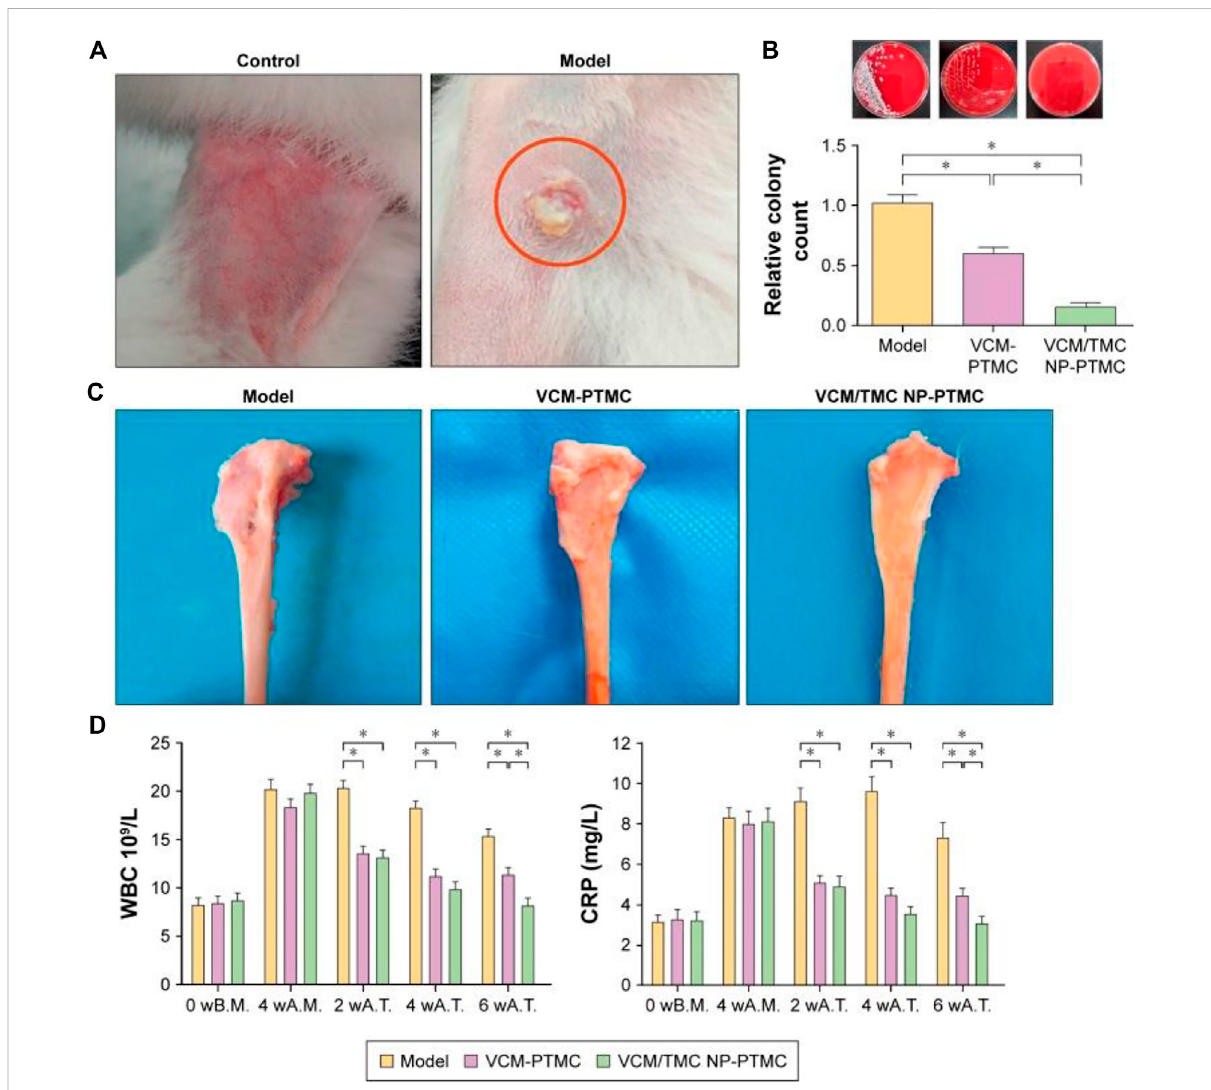
FIGURE 3 The antibacterial activity of VCM-PTMC and VCM/TMC-loaded PTMC nanoparticles. (A) The appearance of the rabbit legs at the fourth week after infection with Staphylococcus aureus . (B) A typical photograph of bacterial colonies forming on sheep blood agar plates and the number of bacterial colonies in the tibia marrow counted following overnight incubation. (C) Typical photographs of the tibia underwent 8 weeks of treatment with VCM-PTMC and VCM/TMC-loaded PTMC. (D) The results of WBC and CRP estimations in the rabbit serum at the time before modeling, fourth week after infection, fourth week after treatment, and eighth week after treatment. * p < 0.05. Reproduced with permission from Zhang et al. (2017). Copyright © 2017 The